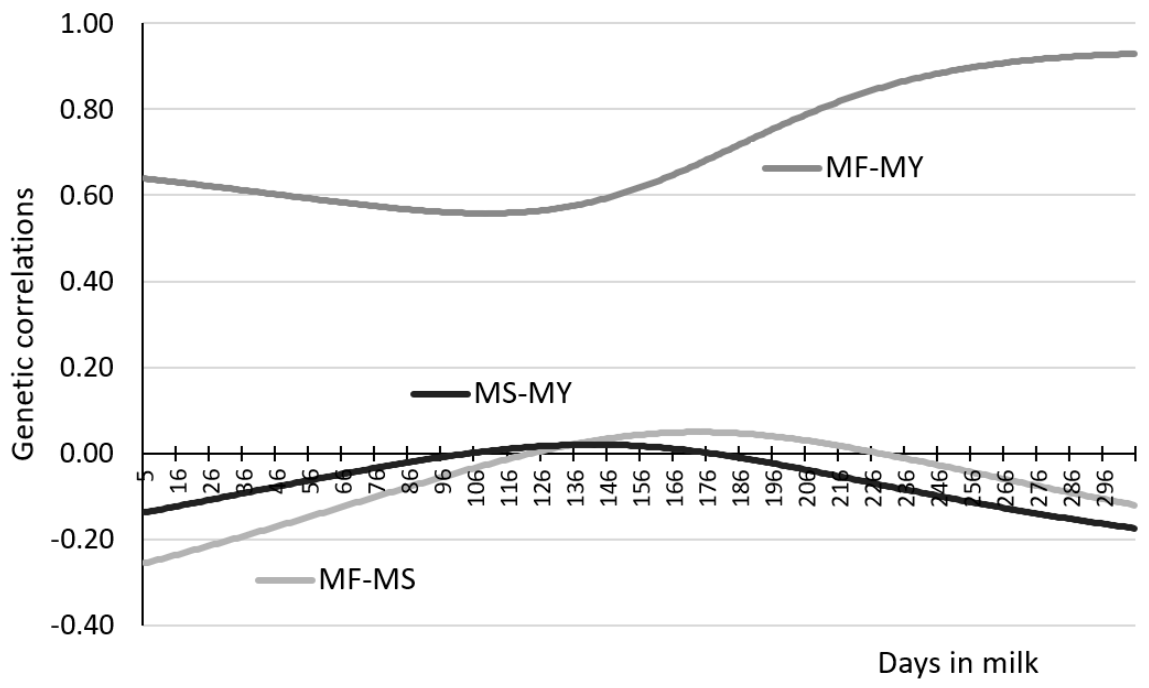
Figure 5. Genetic correlations (rG) for controlled pairs of traits primiparous cows, where MS-MY—milking speed and milk yield covariance, MF-MY—milking frequency and milk yield covariance, MF-MS—milking frequency and milking speed covariance.